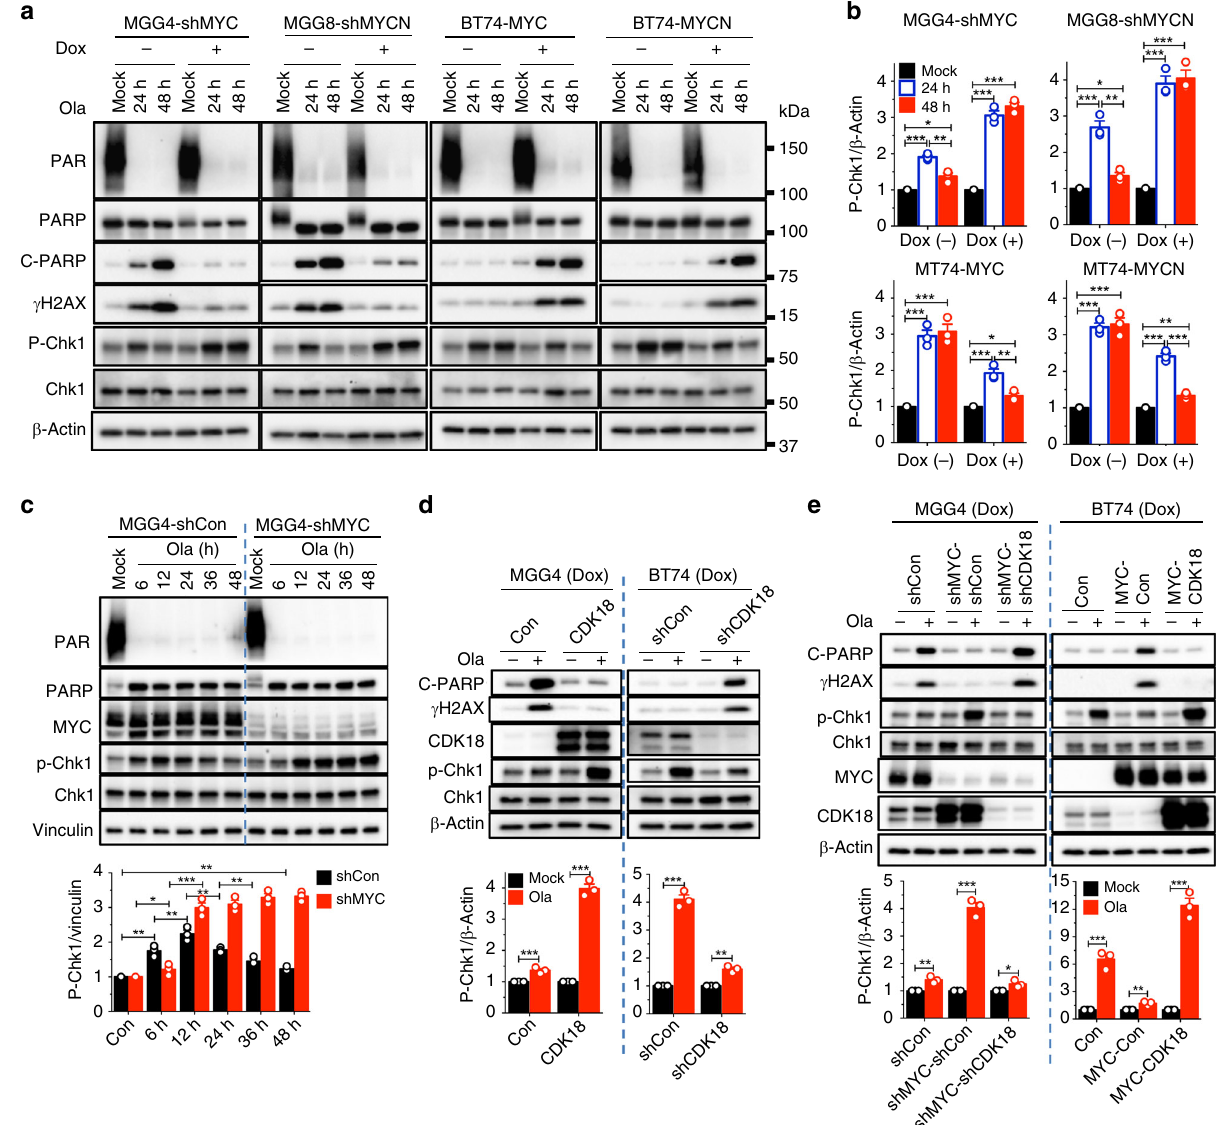
Fig. 5 Myc inhibits and cyclin-dependent kinase 18 (CDK18) promotes ATR signaling in poly(ADP-ribose) polymerase inhibitor-treated glioblastoma stem- like cells (GSCs). a Representative western blots ( n = 3) showing olaparib-induced DNA damage response (DDR) in GSCs with knockdown (sh) or overexpression of MYC and MYCN. Cells treated with mock or olaparib (Ola, 10 μ M) for 24 and 48 h and with ( + ) or without ( − ) doxycycline (Dox). Same membranes and β -Actin control as in Fig. 2d. b Quanti fi cation of p-Chk1 levels determined from a and two additional independent experiments. Normalized to β -Actin. c (upper) Representative western blot ( n = 3) showing kinetics (hours indicated) of p-Chk1 in olaparib-treated (10 μ M) MGG4- shMYC or MGG4-shCon, with Dox. (lower) Quanti fi cation of p-Chk1 levels normalized to Vinculin from (upper) and two additional independent experiments. d (upper) Representative western blots ( n = 3) showing olaparib-induced DDR in MGG4 with CDK18 overexpression or BT74 with CDK18 knockdown after treatment for 48 h with Dox. (lower) Quanti fi cation of p-Chk1 levels from (upper) and two additional independent experiments. With ( + ) or without ( − ) olaparib. e (Upper) Representative western blots ( n = 3) showing olaparib-induced DDR in MGG4 with knockdown of MYC alone (MGG4- shMYC-shCon) and with CDK18 (MGG4-shMYC-shCDK18) or in BT74 overexpressing MYC alone (BT74-MYC-Con) and with CDK18 (BT74-MYC- CDK18), treated as in d . (lower) Quanti fi cation of p-Chk1 from (upper) and two additional independent experiments, normalized to β -Actin. * p < 0.05, ** p < 0.01 and *** p < 0.001, t test. Mean±